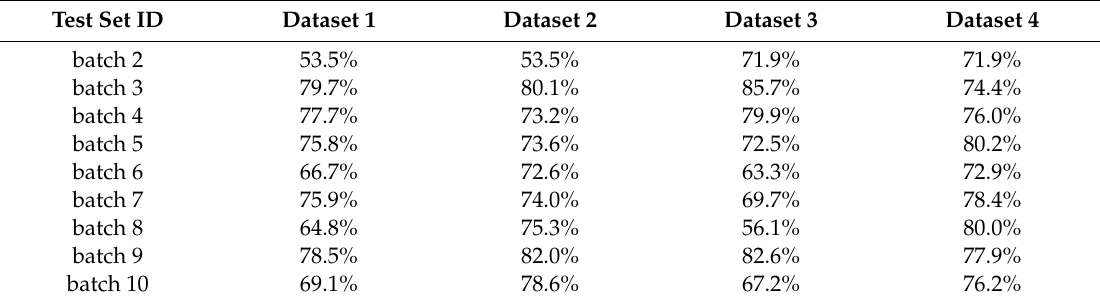
Table 7. Classification Accuracy of the LSTM Model under Four